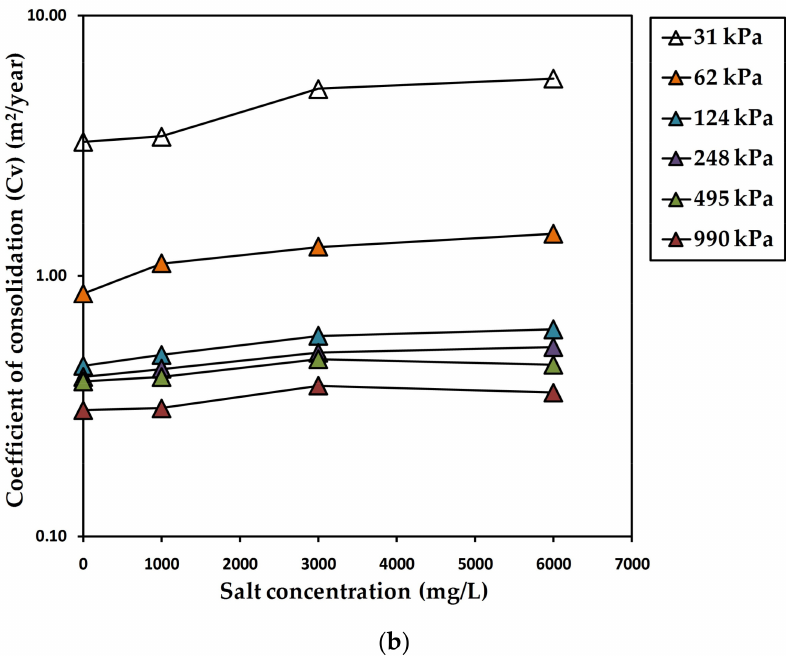
Figure 10. Changes in the coefficient of consolidation ( c v ) versus porewater salt concentration for ( a ) Semarang clay; and ( b ) Demak clay.